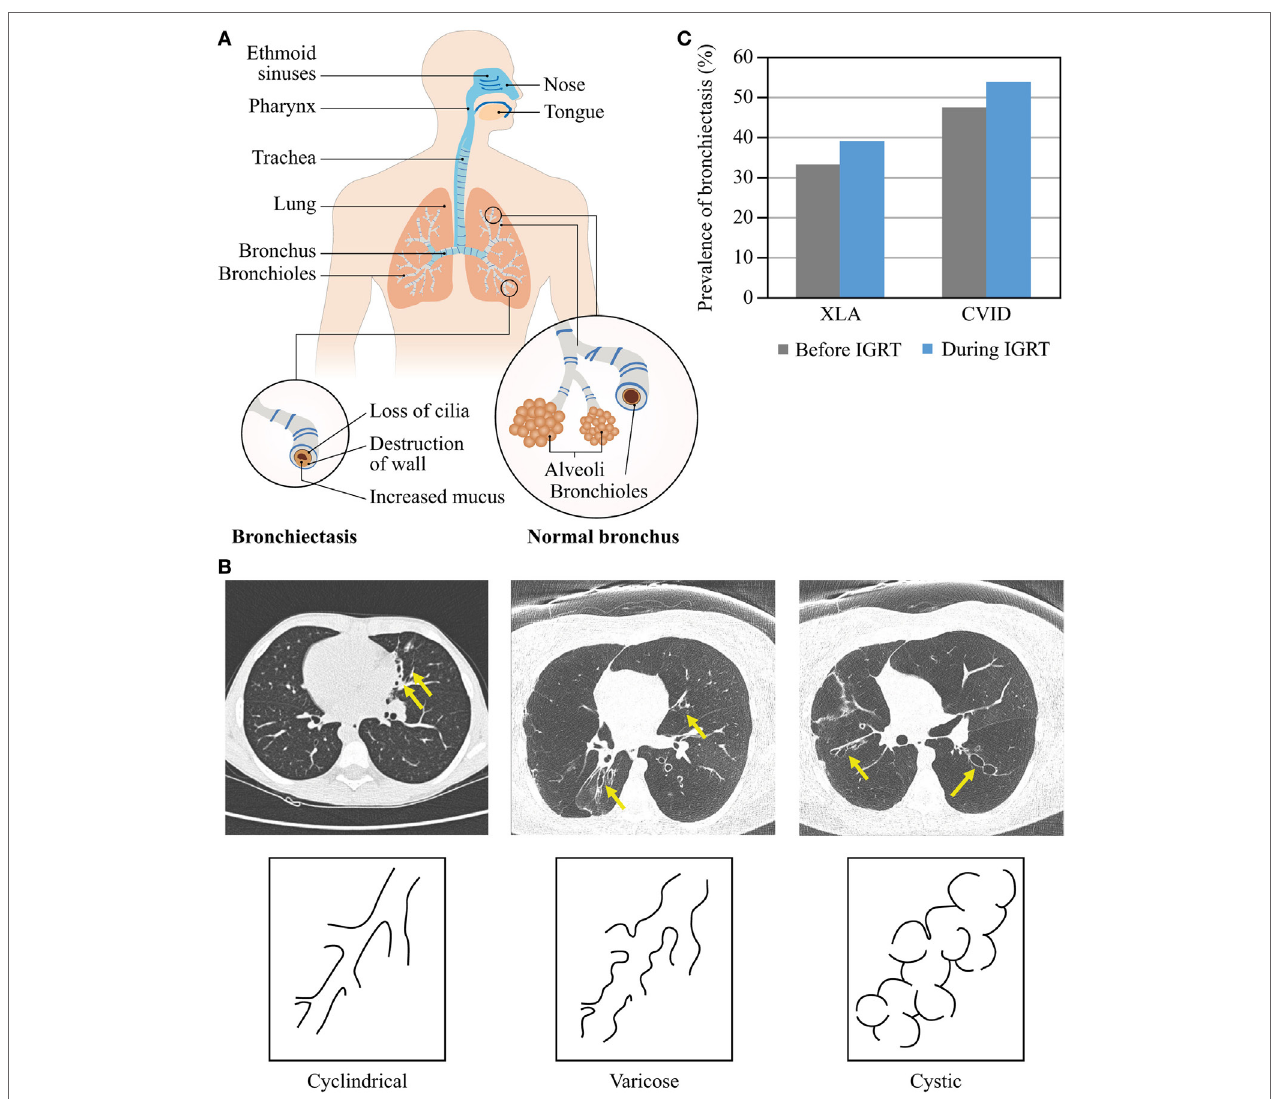
FigURe 4 | Morphology and prevalence of bronchiectasis. (A) Schematic presentation of normal bronchi and bronchi with bronchiectasis. The upper airways (blue) are more exposed to pathogens compared with the lower airways (orange). (B) Types of bronchiectasis. (C) Prevalence of bronchiectasis before and during IGRT. Data are from Quinti et al.